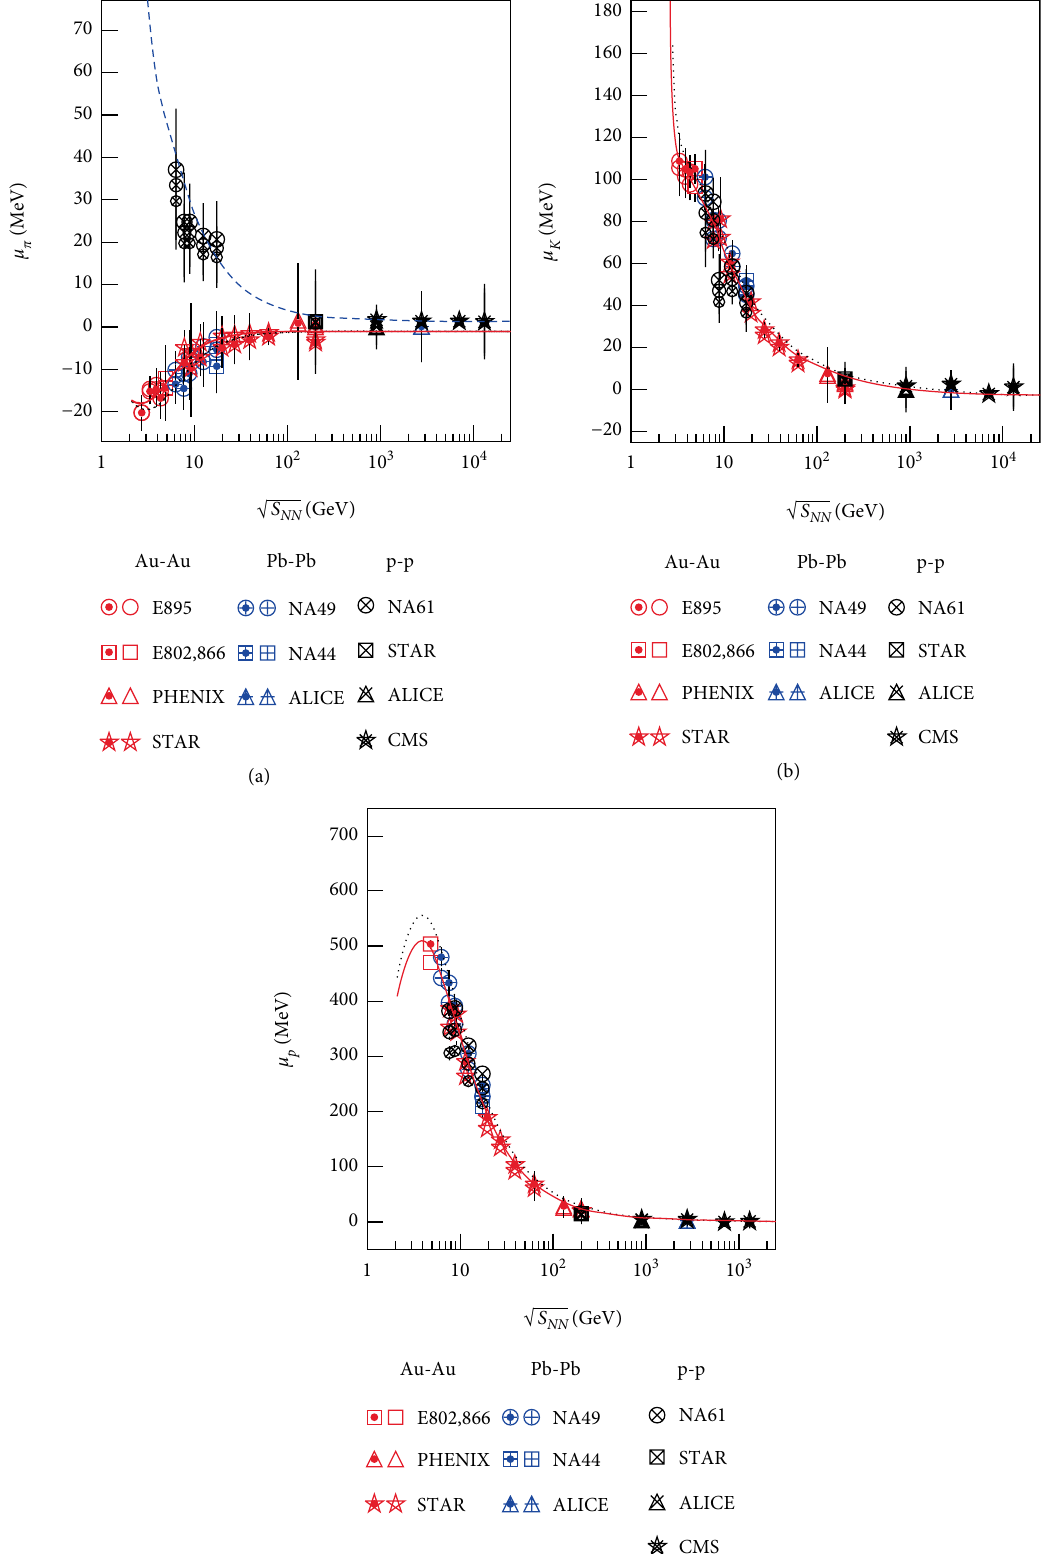
Figure 2: Chemical potentials, (a) Au-Au collisions, central Pb-Pb collisions, and INEL or NSD symbols denote the derivative data obtained from Figure 1 according to Equation (5). The normal, medium, and small symbols with diagonal crosses denote the derivative data in INEL or NSD surrounded the symbols are the derivative results obtained from the curves in Figure 1 according to Equation